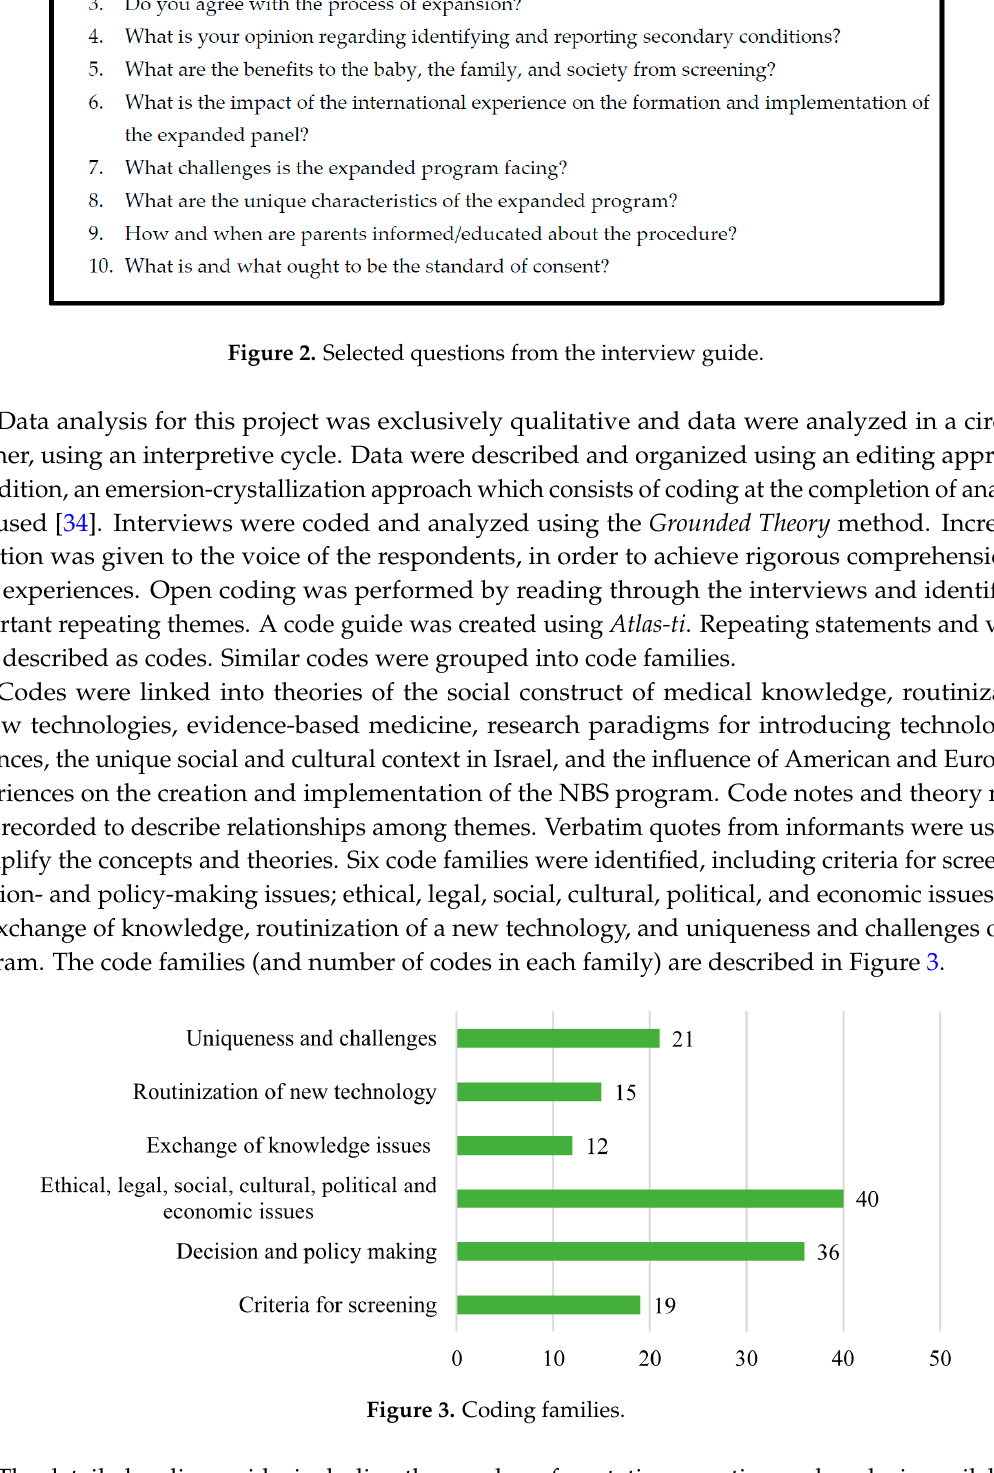
Figure 3. Coding families.